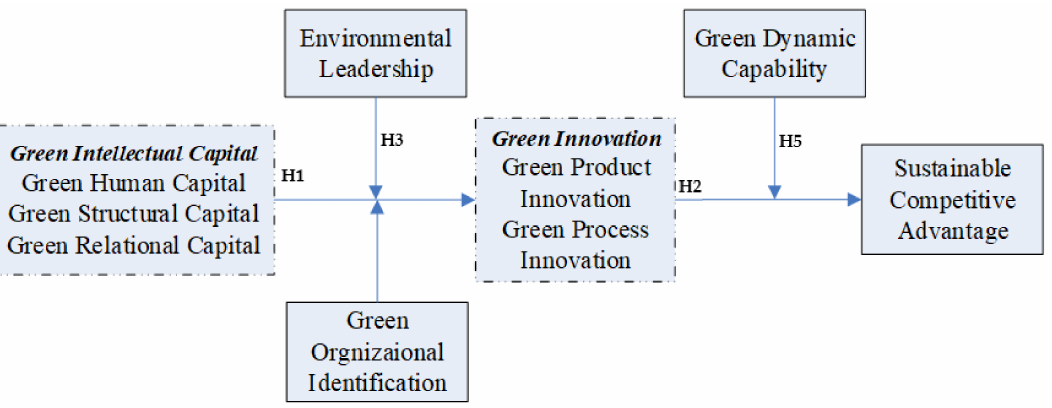
Figure 1. Conceptual